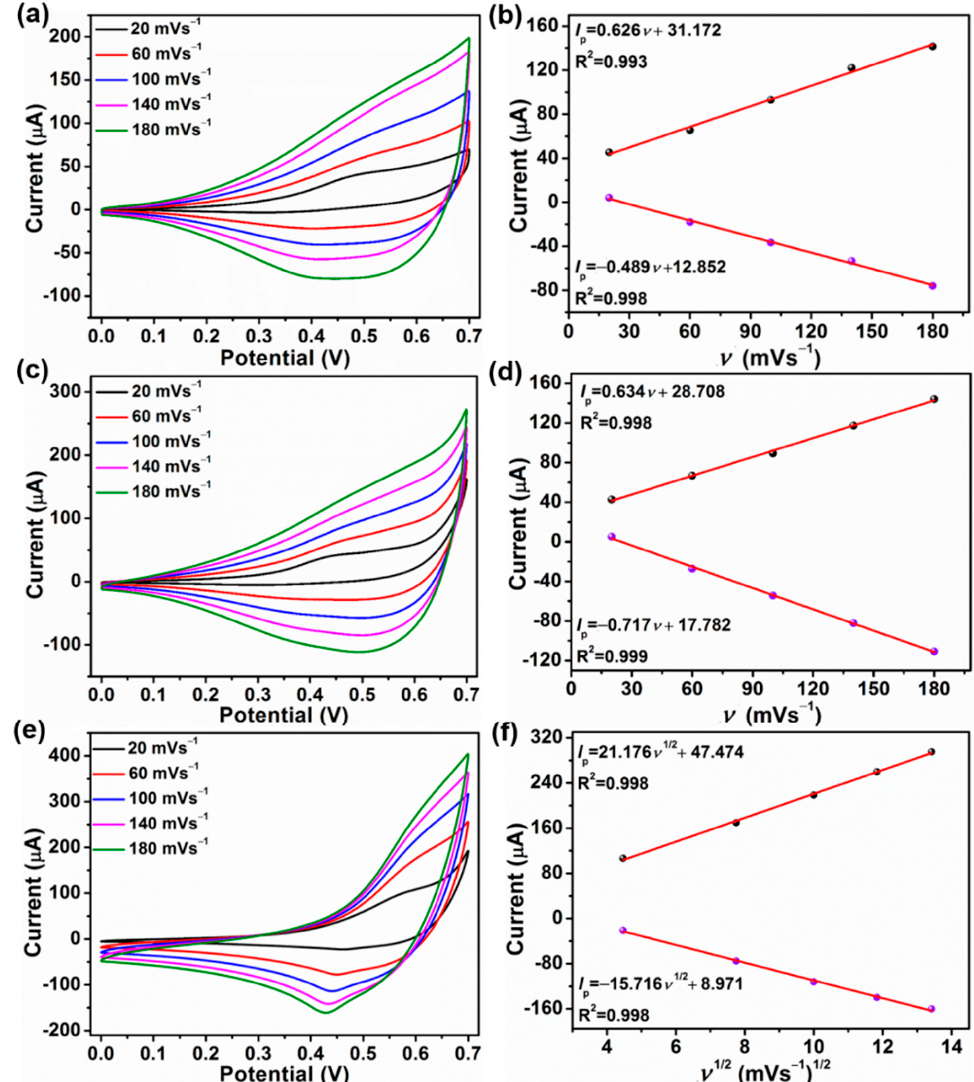
Figure 6. CV curves at different scan rates (20–180 mV s − 1 ) in a 1 mM glucose solution ( a ) CuS, ( c ) Co-CuS-1, ( e ) Co-CuS-2, and the corresponding linear calibration curves, ( b ) CuS, ( d ) Co-CuS-1, ( f ) Co-CuS-2, respectively.